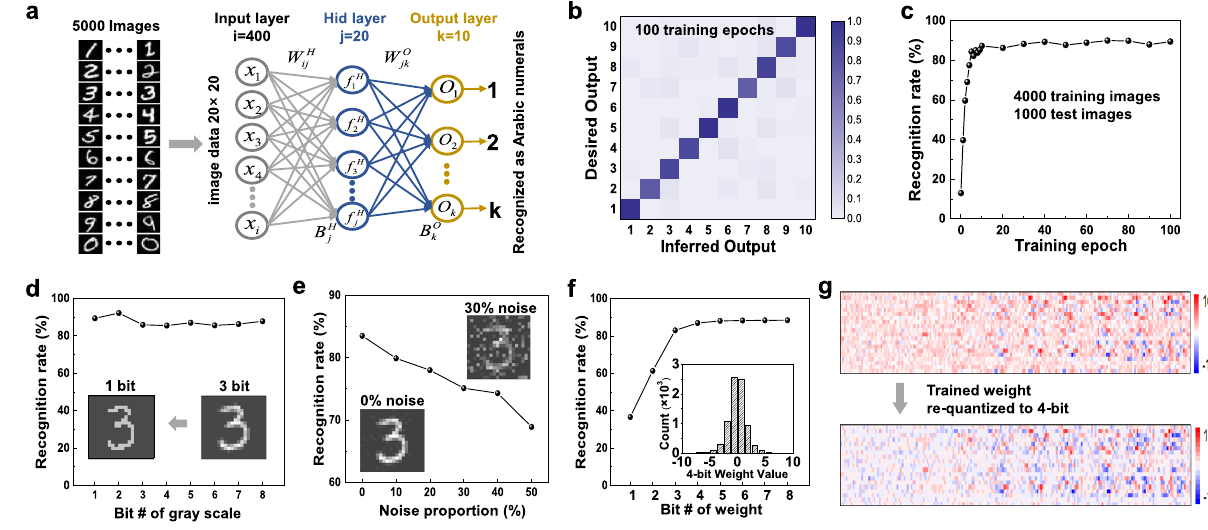
Fig. 5 Fully connected neural network simulation for handwritten digit recognition based on experimental data. a Neuromorphic network with three layers, each containing 400 input neurons, 20 hidden neurons, and 10 output neurons. Where W ij H denotes the weight between the input neuron i and the hidden neuron j, f H denotes the convolution value of hidden neurons j, O k denotes the convolution value of the output layer, and B j H is the bias of hidden j neuron j. b Confusion matrix of the test results under 100 training epochs, with 4000 images used for training and 1000 images used for testing. The output 0 – 9 denotes the desired output handwritten digits. c Recognition rate as a function of training epoch (0 – 100), using 4000 images for training and 1000 images for testing. d The relationship between the recognition rate and the grayscale bit depth; the inset shows 1-bit and 3-bit grayscale input images.